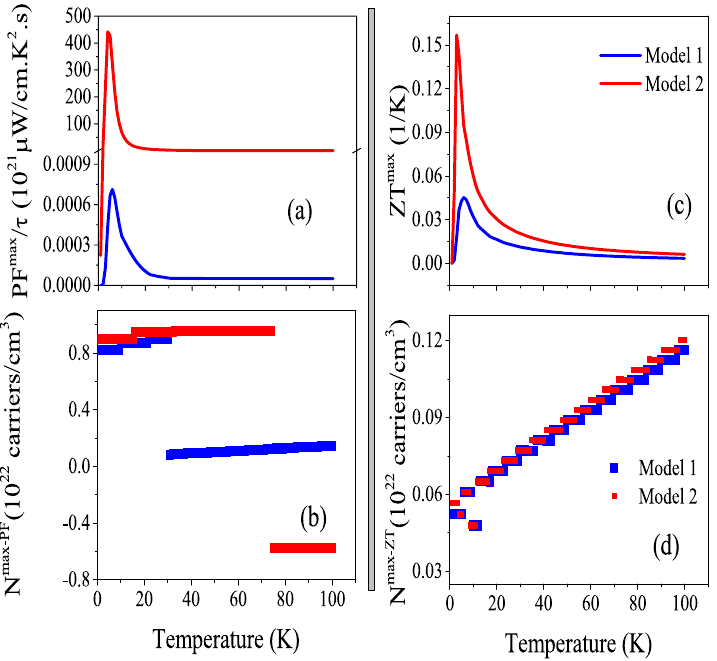
max Z max e ) of CeIn 3 τ and ( c ) electrical Z (